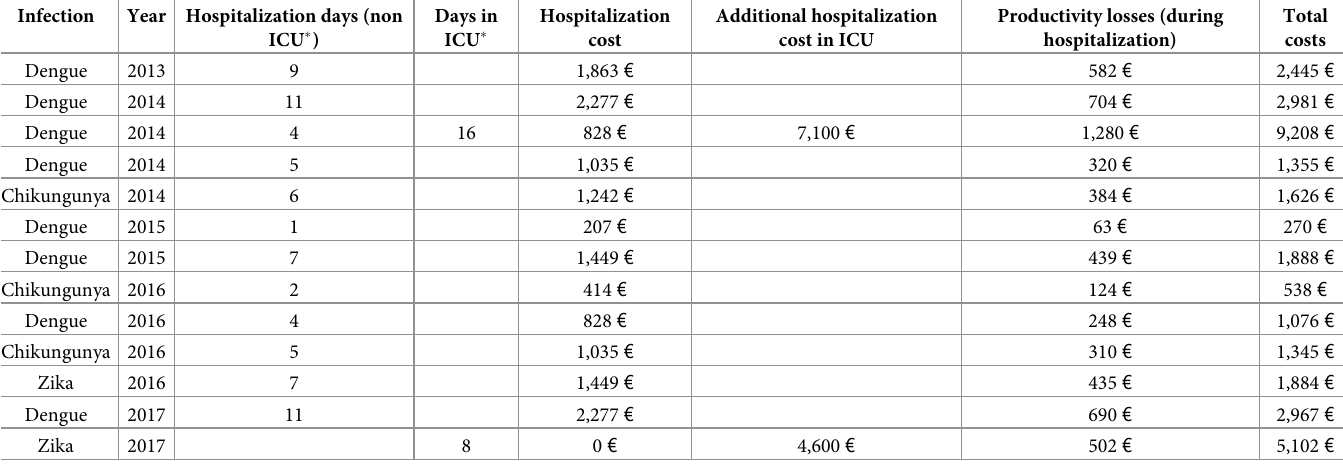
Table 1. Cost of illness for reported imported cases of Dengue, Chikungunya and Zika virus in Greece for the period 2013–2017.